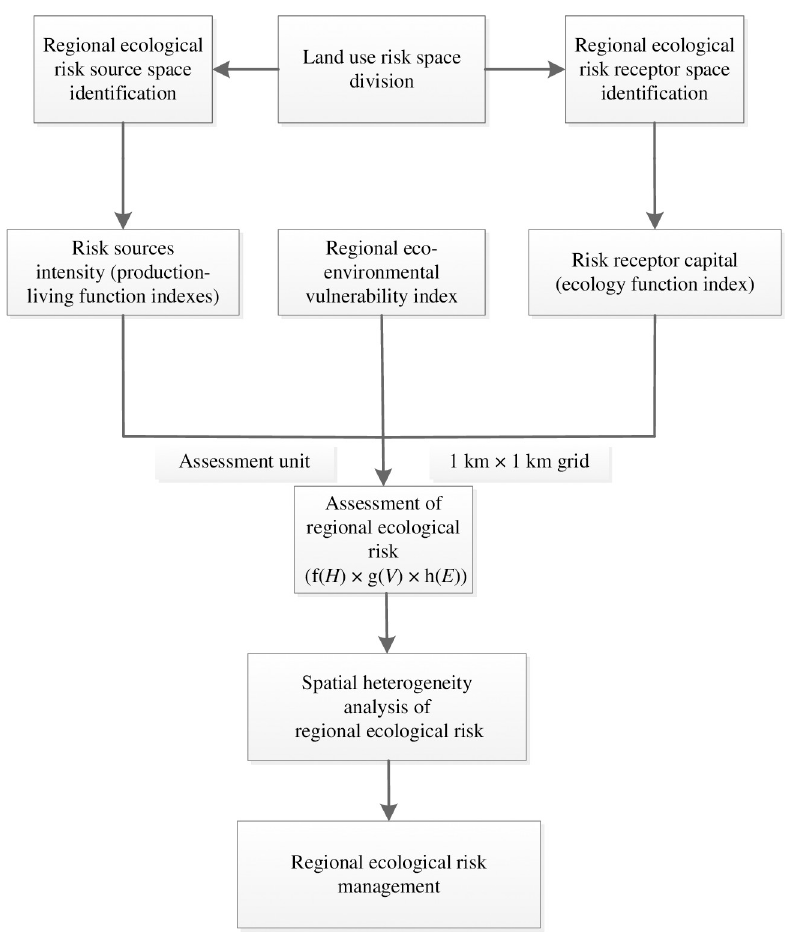
Fig 3. Framework of RERA in the